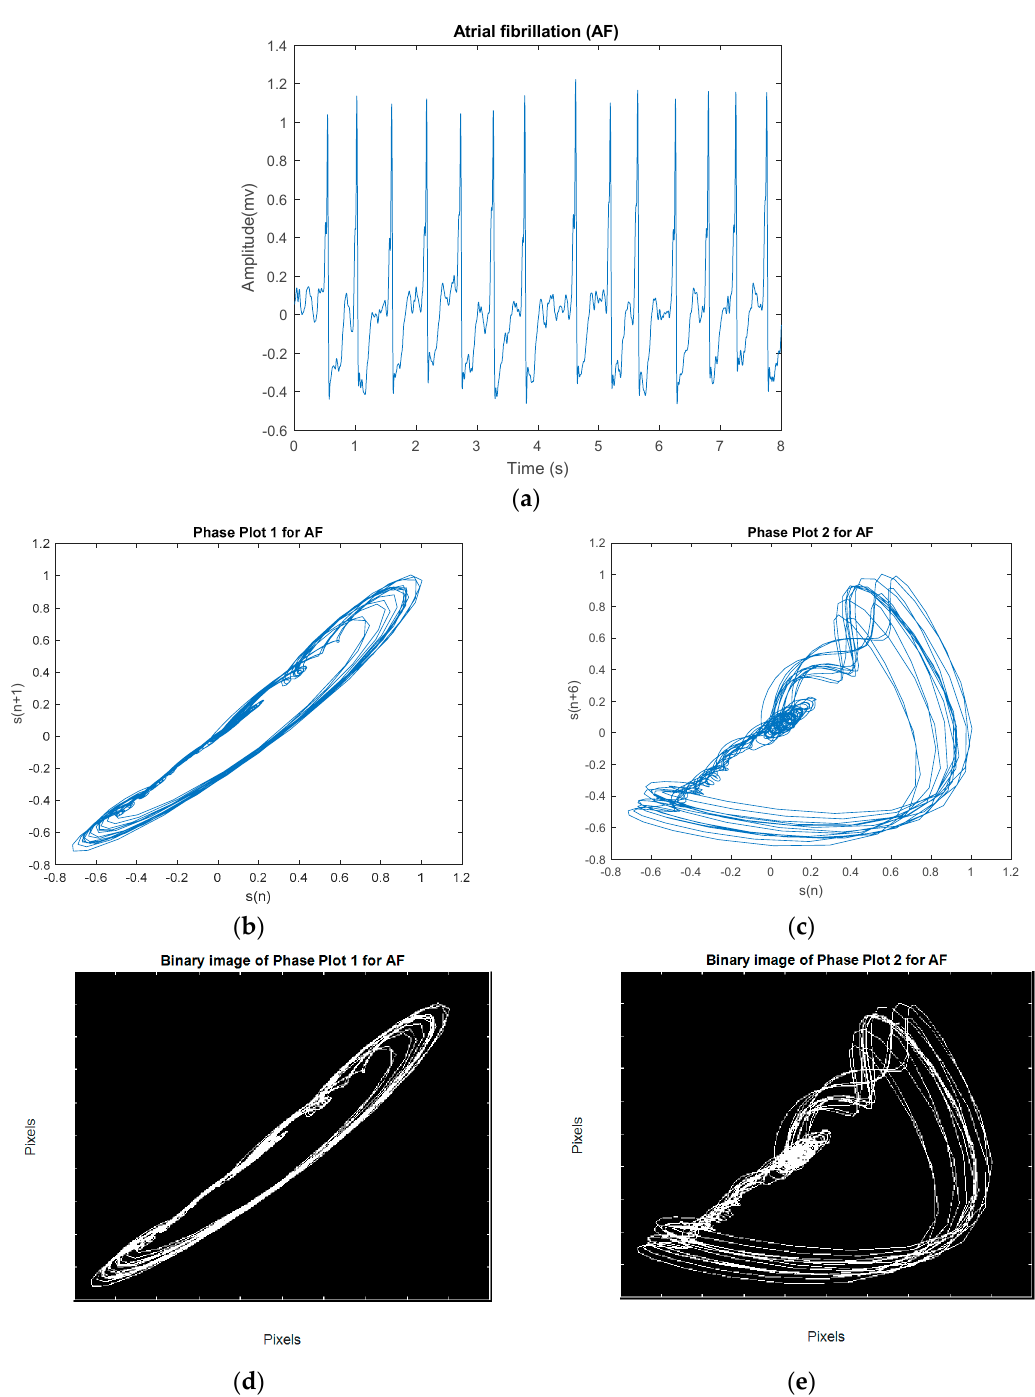
Figure 5. ( a ) An example AF segment. ( b ) Phase plot of segment with a 1-sample lag. ( c ) Phase plot of segment with a 5-sample lag. ( d ) Related binary image of ( b ). ( e ) Related binary image of ( c ).